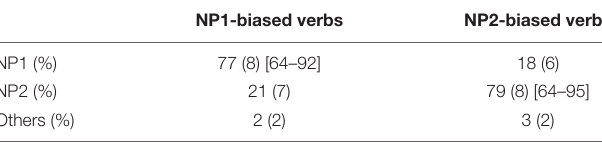
TABLE 1 | Mean referential probability of NP1-biased verbs and NP2-biased